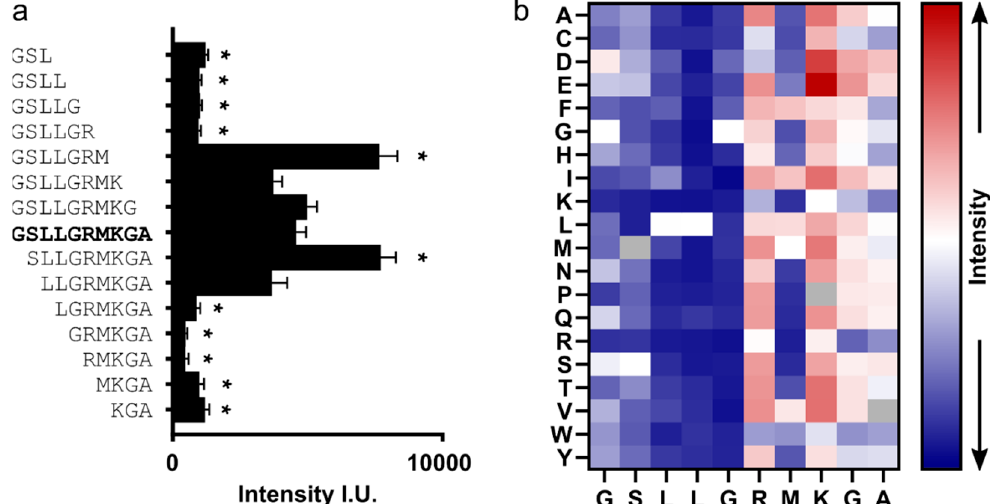
Figure 6. Relative binding strength of P2-permutations and terminal truncations to WT-HBc. ( a ) Chemiluminescent-based intensity readout of WT-HBc binding to N-terminally or C-terminally truncated P2 variants. Higher intensity correlates to the stronger binding. Mean + SEM. Sequences marked with a star differ significantly from the no truncated sequence (“GSLLGRMKGA”). Significance determined using ANOVA test with a follow-up Dunnett’s test for multiple comparisons. p < 0.0001. n = 12; ( b ) heat map of positional point mutation microarray screen of P2 to WT-HBc. Shown are intensity values of point-mutated variants normalized to the corresponding WT P2 sequence (“GSLLGRMKGA”). Higher spot intensity (red) correlates with stronger binding and vice versa (blue). Gray color indicates n/a. In the horizontal direction, the positions of P2 are shown; in the vertical direction, the respective point mutation is indicated. Values are presented as the mean of n = 4. The raw chemiluminescent readout data are shown in Figure S6.